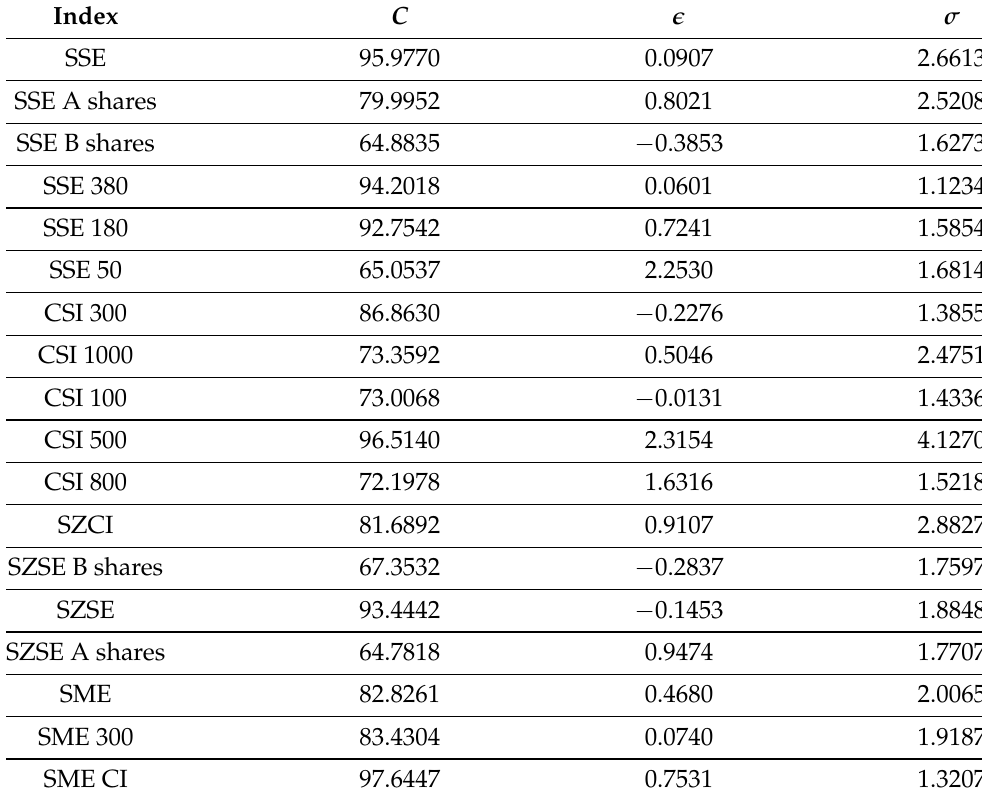
Table 5. SVR parameters obtained by short-term bat algorithm